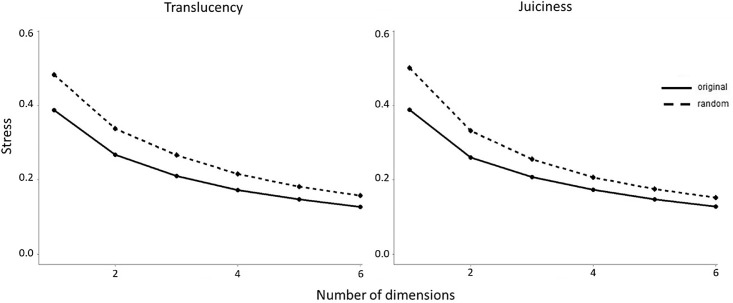
Scree plots showing the stress values as a function of the number of dimensions. The solid line represents the scree plot for the original values, and the dashed line shows the scree plot of the random data obtained from the average of the permutations. (Left) Scree plot for translucency NMDS space. (Right) Scree plot for juiciness NMDS space.